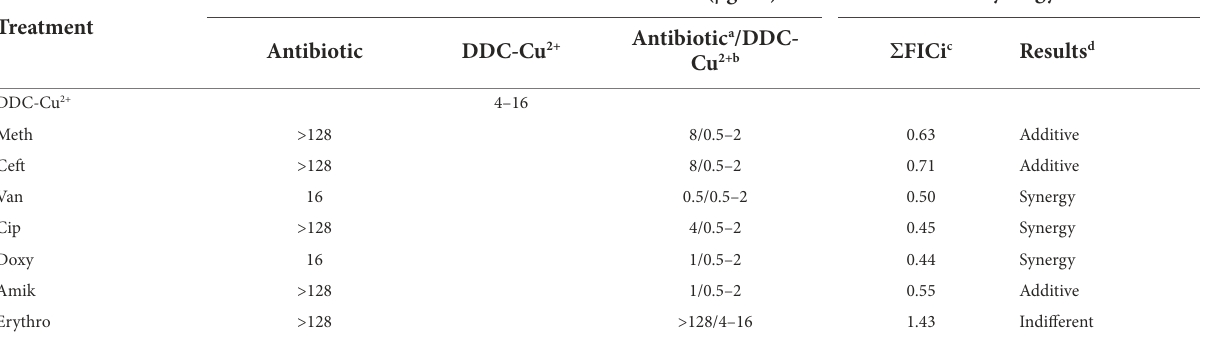
TABLE 4 Minimal concentration to kill over 80% biofilm and synergistic effects of antibiotics, diethyldithiocarbamate and Cu 2+ (DDC-Cu 2+ ) and the combination against MRSA Mu50 ( n = 3).